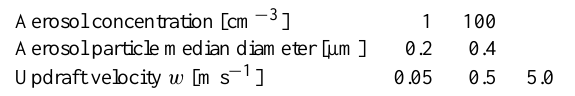
Table 2. Overview of updraft velocities and aerosol properties as used for the trajectories calculated with the box model